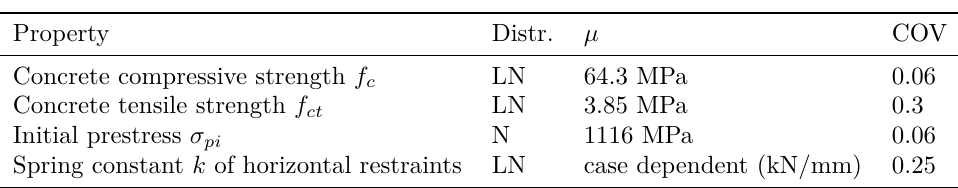
Table 3. Probabilistic models for most important basic variables involved in the uncertainty quantification of the compressive membrane action in the investigated hollow core slabs.